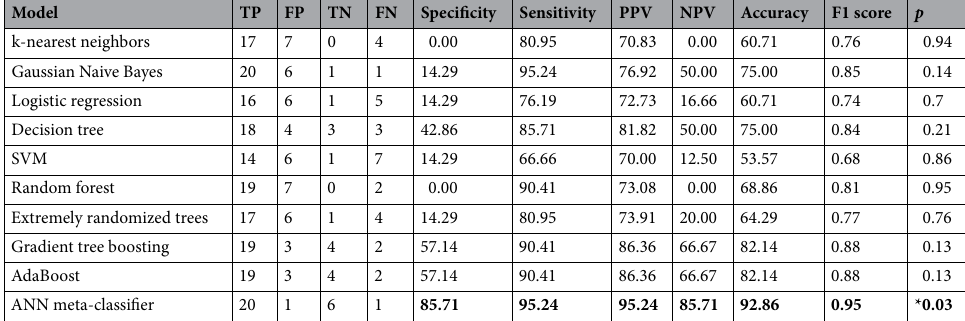
Table 1. Classifier performances. Bold values indicate best performing classifier. TP = true positives, FP false positives, TN true negatives, FN false negatives, PPV positive predictive value, NPV negative predictive